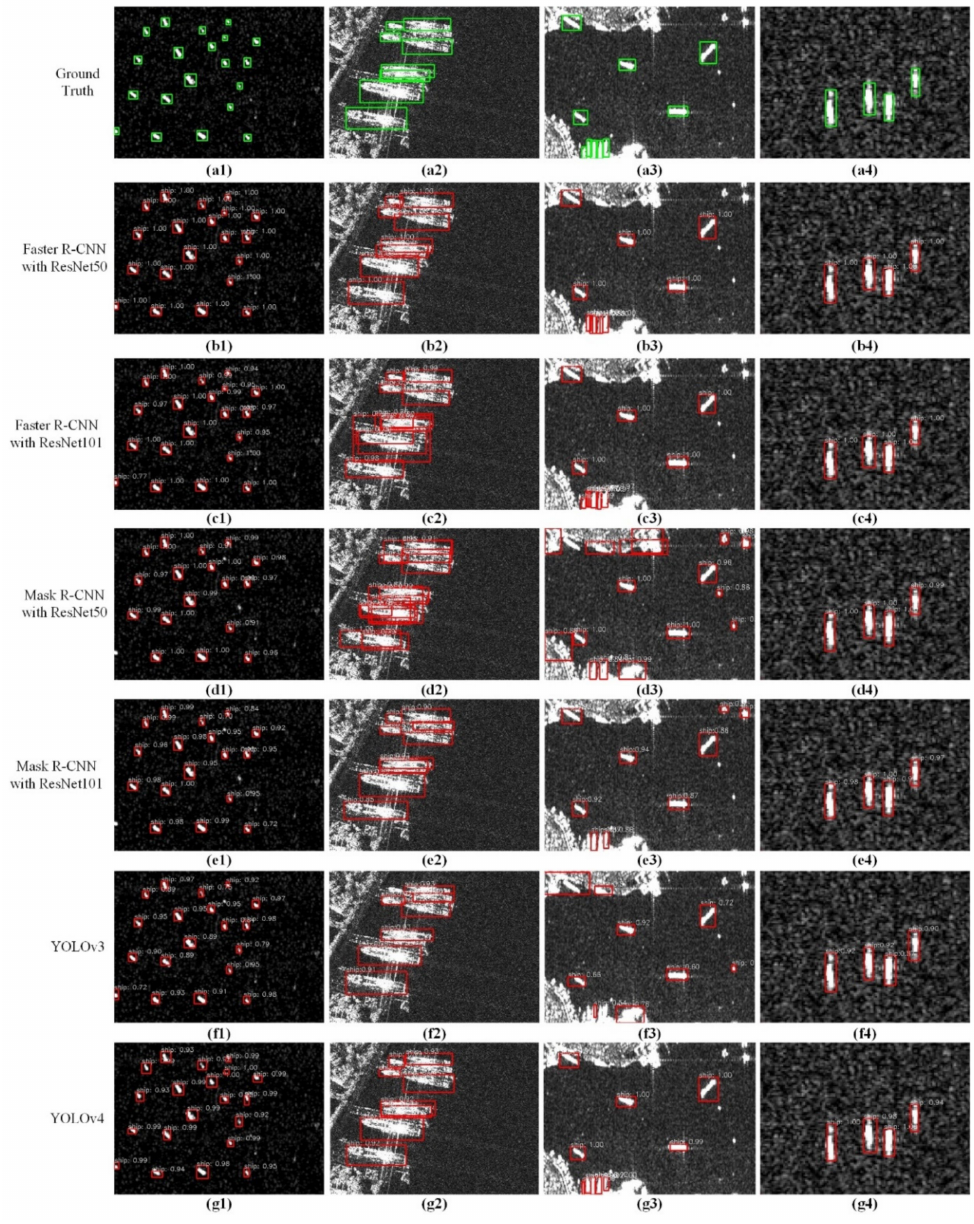
Figure 11. Experimental results on SSDD. ( a1 – a4 )The first row contains ground truth images. ( b1 – b4 ) The second row contains the results of Faster R-CNN with ResNet50. ( c1 – c4 ) The third row contains the results of Faster R-CNN with ResNet101. ( d1 – d4 ) The fourth row contains the results of Mask R-CNN with ResNet50. ( e1 – e4 ) The fifth row contains the results of Mask R-CNN with ResNet101. ( f1 – f4 ) The sixth row contains the results of YOLOv3. ( g1 – g4 ) The seventh row contains the results of